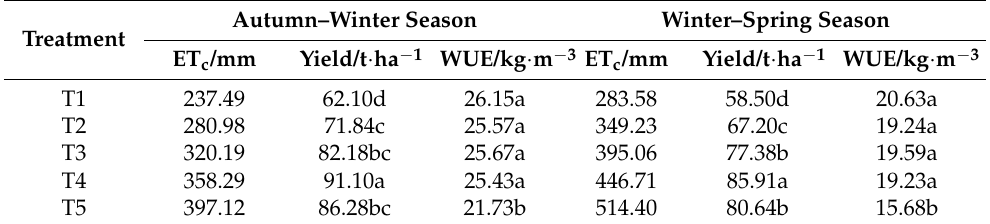
Table 4. Tomato fruit yield and water use efficiency (WUE) of each treatment in a solar greenhouse.